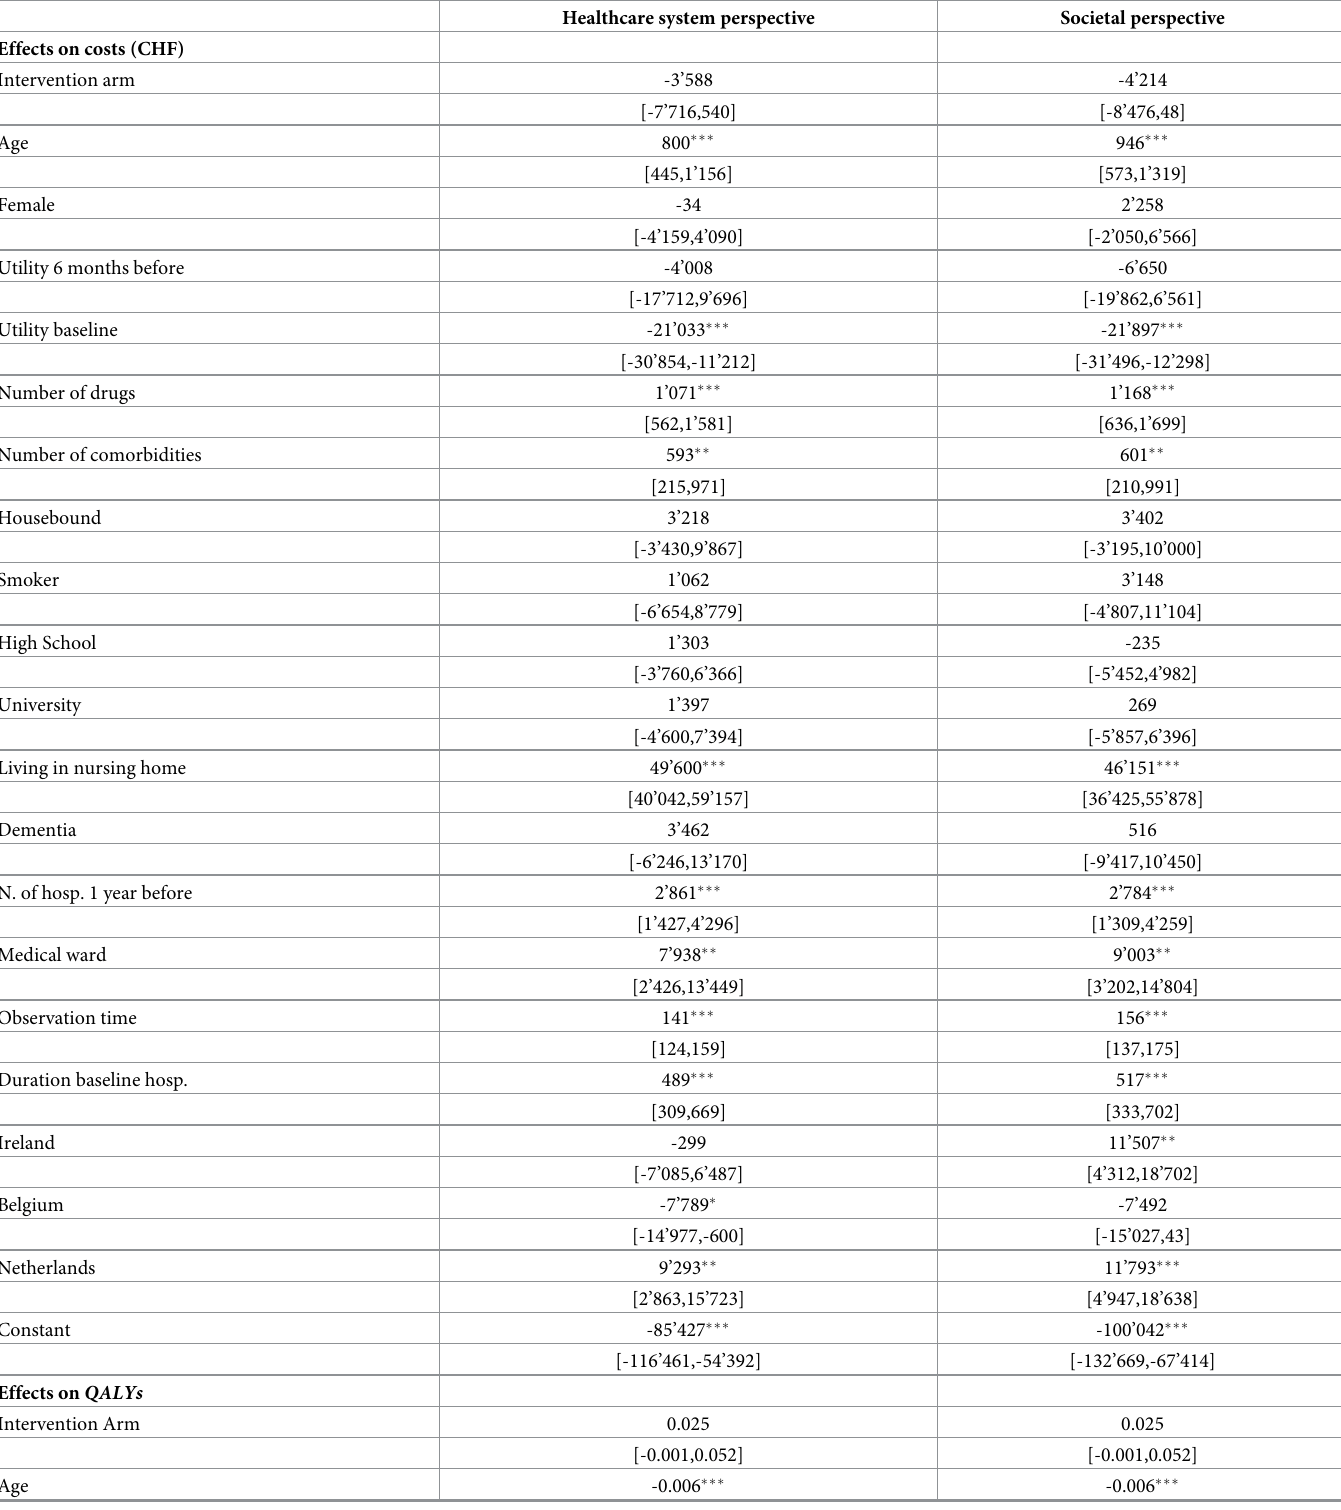
Table 3. Results of the main cost-effectiveness analysis, GSEM